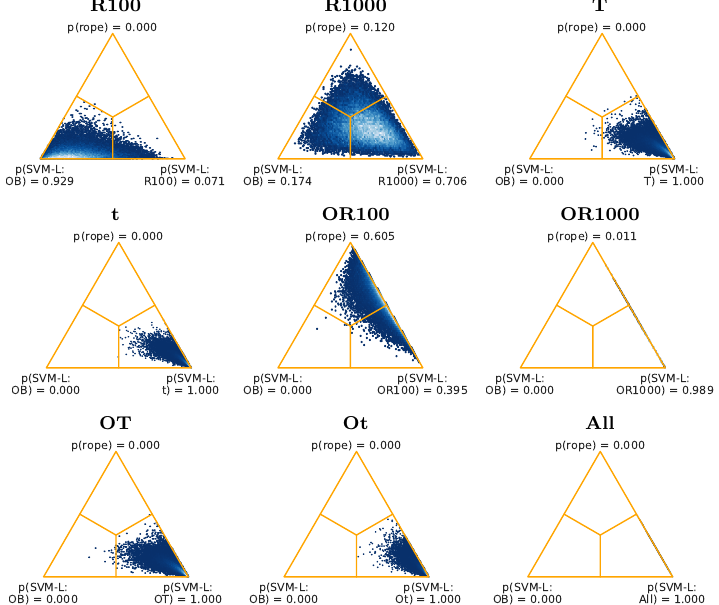
Figure 11. Posteriors for the Bayesian sign-rank tests for SVM-L, from the difficult